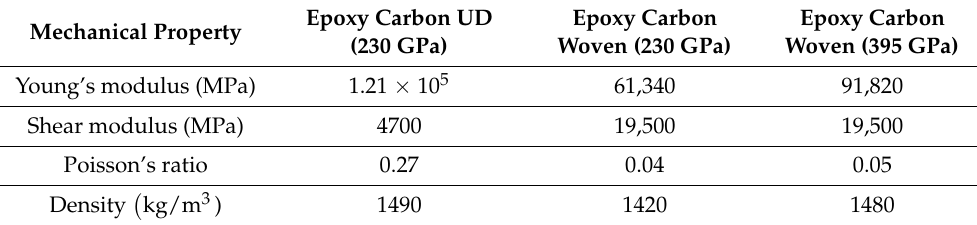
Table 2. Mechanical properties of composite materials.